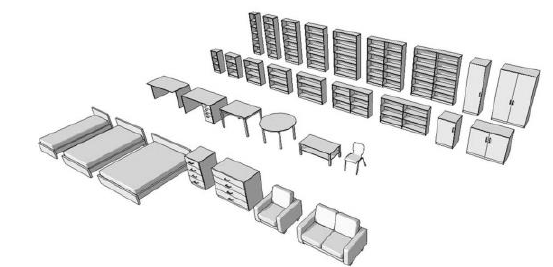
Figure 1 . Graphisoft ARCHICAD Library Part Maker. (source: https://www.thenbs.com/knowledge/graphisoft-archicad-library- part-maker-the-easy-way-to-create-data-rich-objects).